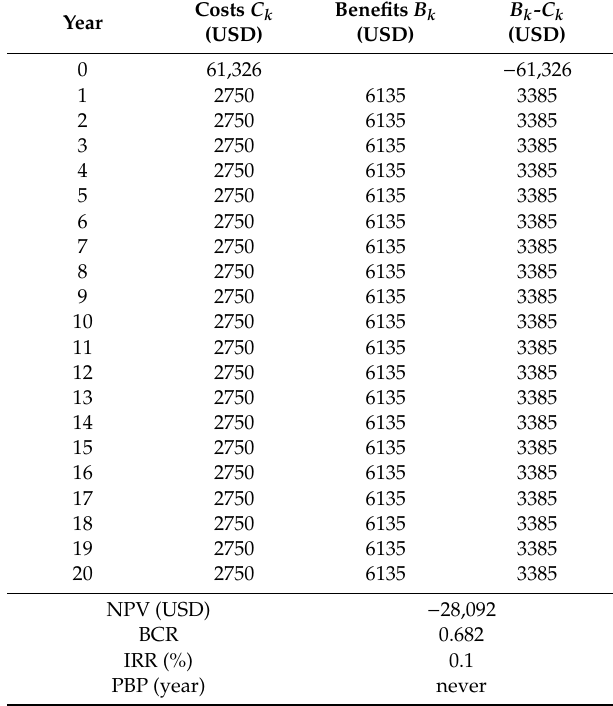
Table 7. Economic Analysis: cost-benefit flows and economic